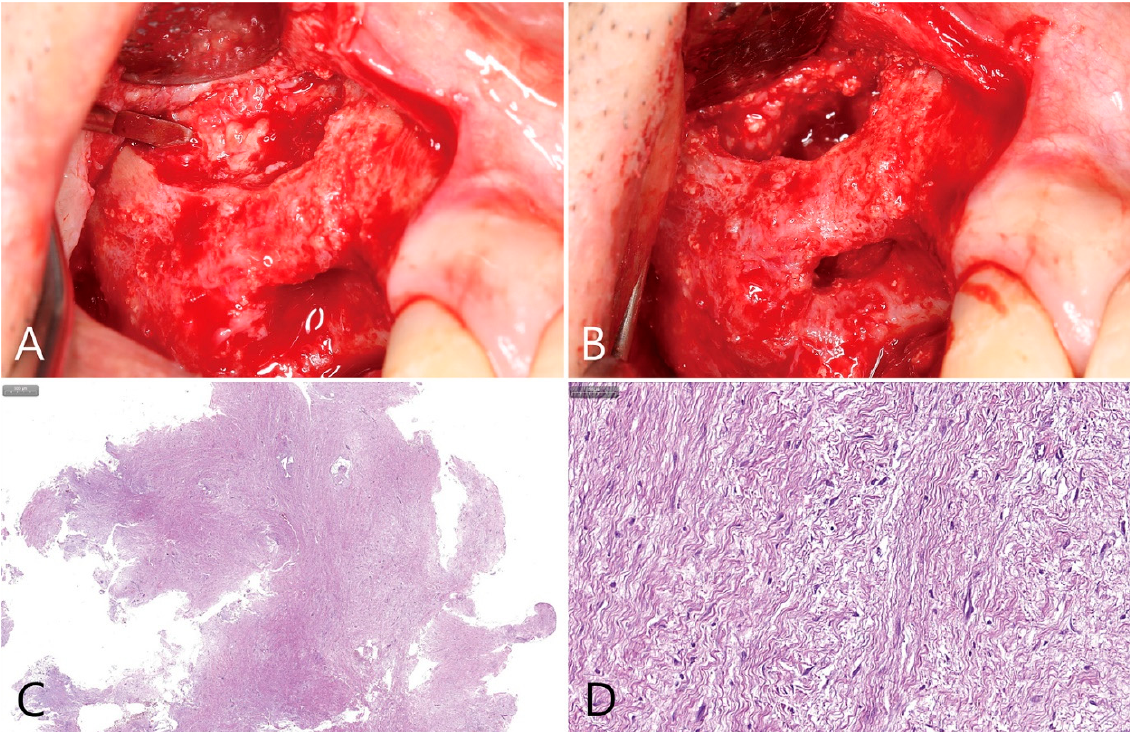
Figure 9. ( A ) Six months after surgery, the flap for implant placement was reflected. At this time, the grafting void was accessed through the lateral window site; ( B ) the specimen was very fibrotic and was removed using a curette. The specimen was not well separated from the surrounding regenerated bone tissue. This may compromise the apical bony support for future implant placement; ( C ) the surface of the removed specimen was very irregular and no ciliated columnar epithelium was observed; ( D ) at high magnification, dense fibrotic tissue was observed and there was no infiltration of inflammatory cells.